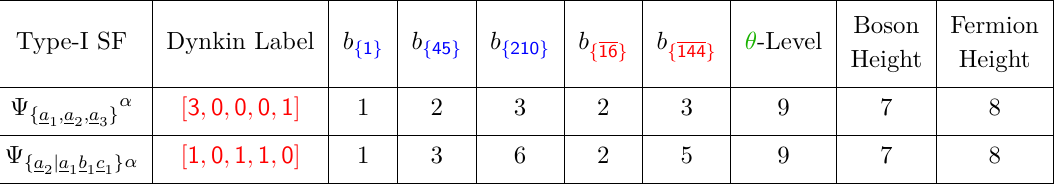
Table 5 . Type-I Superfield Contributions to Bosons at Level-16 & Fermions at Level-17 in Type-IIB Scalar Superfield